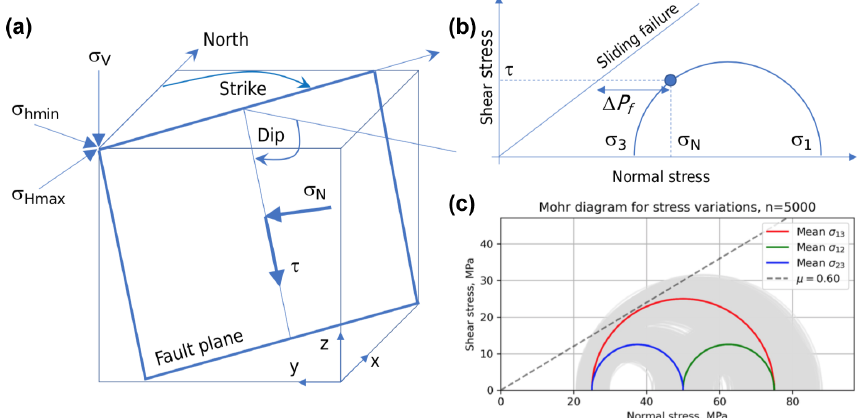
Figure 1. (a) Schematic block diagram of a fault plane showing the terminology used in this paper. Also shown are the Cartesian and geographic reference frames and the Andersonian principal stresses. (b) Mohr diagram for a given state of stress (blue semicircle) with normal ( σ n ) and shear stresses ( τ ) marked for a selected fault plane orientation (blue dot). Failure envelope for frictional sliding (cohesion = 0) is also shown as a straight blue line. (c) Mohr diagram depicting one of the key issues tackled in this paper: given uncertainty in the input stress values (grey Mohr circles for the variation around the average principal stresses in red, blue, and green), what is the probability of failure; i.e. what percentage of all of these stress states will intersect the failure envelope?